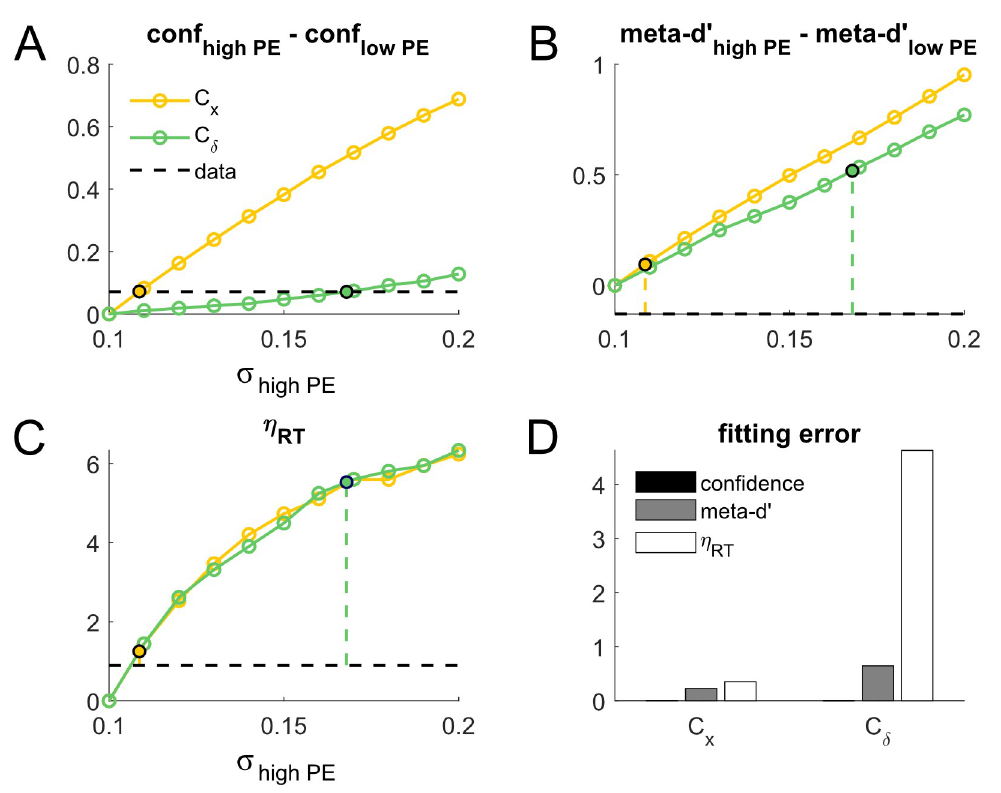
Fig 5. Comprehensive simulations showing fitting procedures for the main C x model and alternative C δ model for Koizumi et al.’s [10] Experiment 2B. As in the analysis of Koizumi et al.’s Experiment 1A in Fig 3, we examined performance-matched confidence differences, performance-matched meta-d’ differences, and relative RT effect sizes as a function of PE level. (A) For each of the C x and C δ models, we determined the level of sensory evidence noise in the High PE ( σ high PE ) condition that best matched the observed magnitude of confidence differences in the empirical data (dashed horizontal line), marked with black circles. We then “read out” the predicted meta-d’ differences (B) and relative RT effect sizes (C). (D) We also computed fitting error for each model as the difference between the simulated and empirical confidence differences, meta-d’ differences, and relative RT effects (D). As with Experiment 1A, the C x model produced a good fit to the empirical data across the entire spectrum of measures considered, whereas the alternative C δ model produced substantial errors for predicted meta-d’ and RT when made to match the empirically-observed confidence differences.